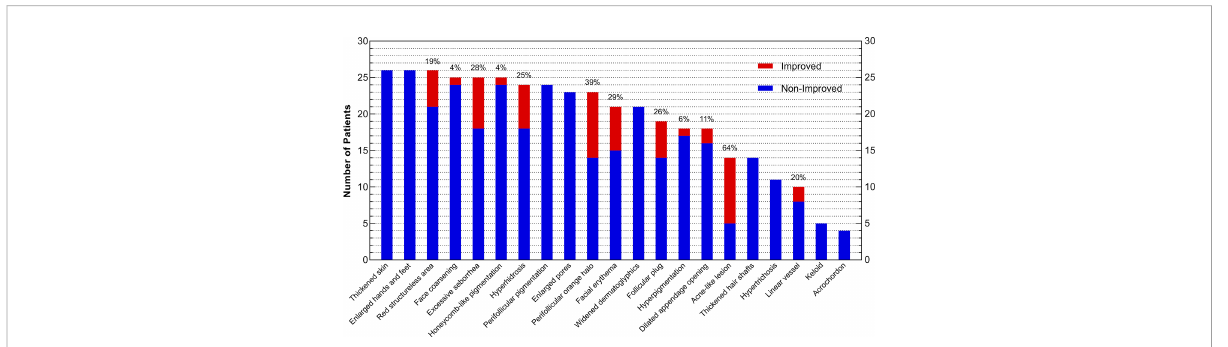
FIGURE 2 Improvement of Skin Lesions in Acromegaly Patients after Surgery. The x-axis presents 21 skin lesions, and the y-axis indicates the number of patients who had improvement (red) or non-improvement (blue) of skin lesions after surgery. The whole column (red plus blue) represents the number of patients with skin lesions before surgery, and the percentages laid on the top of columns mean the rates of skin lesion improvement (red) after surgery.